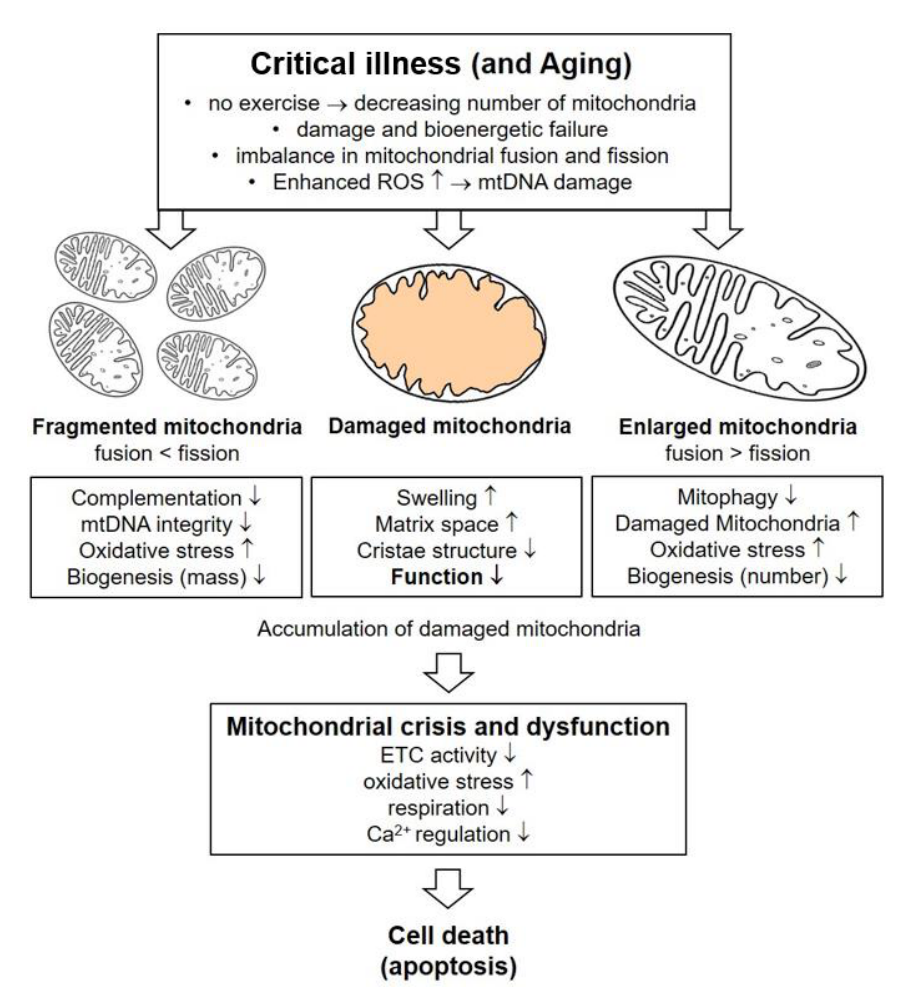
Figure 3. Impact of critical illness on mitochondrial dynamics in skeletal muscle cells. Interference with the homeostatic regulation of mitochondrial fusion and fission pathways, resulting in abnormal mitochondrial morphology. The presence of fragmented mitochondria due to a decrease in fusion and/or an increase in fission may compromise mtDNA integrity, mitochondrial structural and functional complementarity and mitochondrial biogenesis. Each one can lead to mitochondrial dysfunction. Conversely, the formation of enlarged mitochondria as a result of decreased fission and/or increased fusion events may decrease mitochondrial turnover by impairing mitophagy and biogenesis. This leads to the accumulation of damaged mitochondria in the cells. Critical diseases can cause bioenergetic failure, increased formation of ROS and imbalances in homeostatic regulation which damage mitochondria, leading to swelling, increases in matrix space, decreases in cristae structure and decreases in functionality. Accumulation of dysfunctional mitochondria in the cells finally results in cell death. ETC: electron transport chain, mtDNA: mitochondrial desoxyribonucleic acid, ROS: reactive oxygen species.